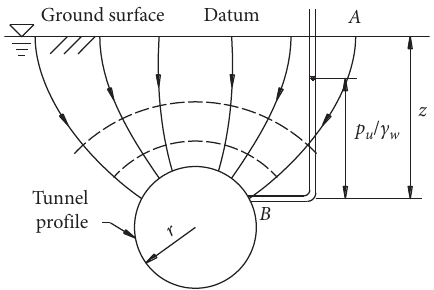
Figure 1: Diagram of hydraulic head around